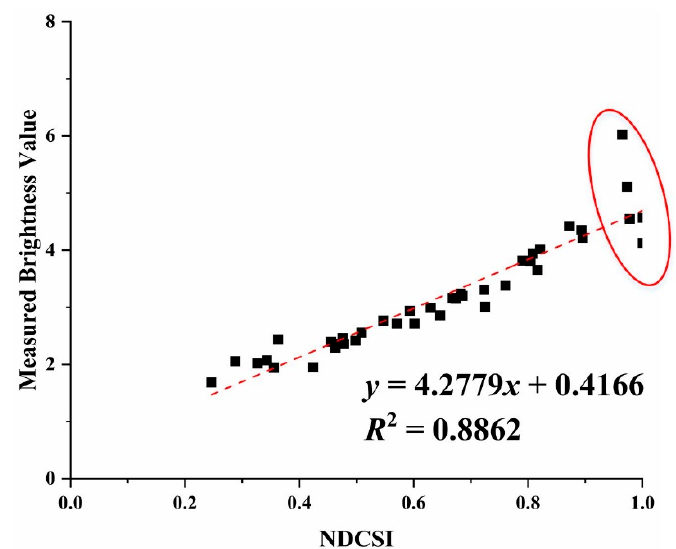
Figure 7. Scatterplot of NDCSI and measured brightness values for sub-area samples. Five values (circled in red) had a poor linear correlation because of illumination saturation.